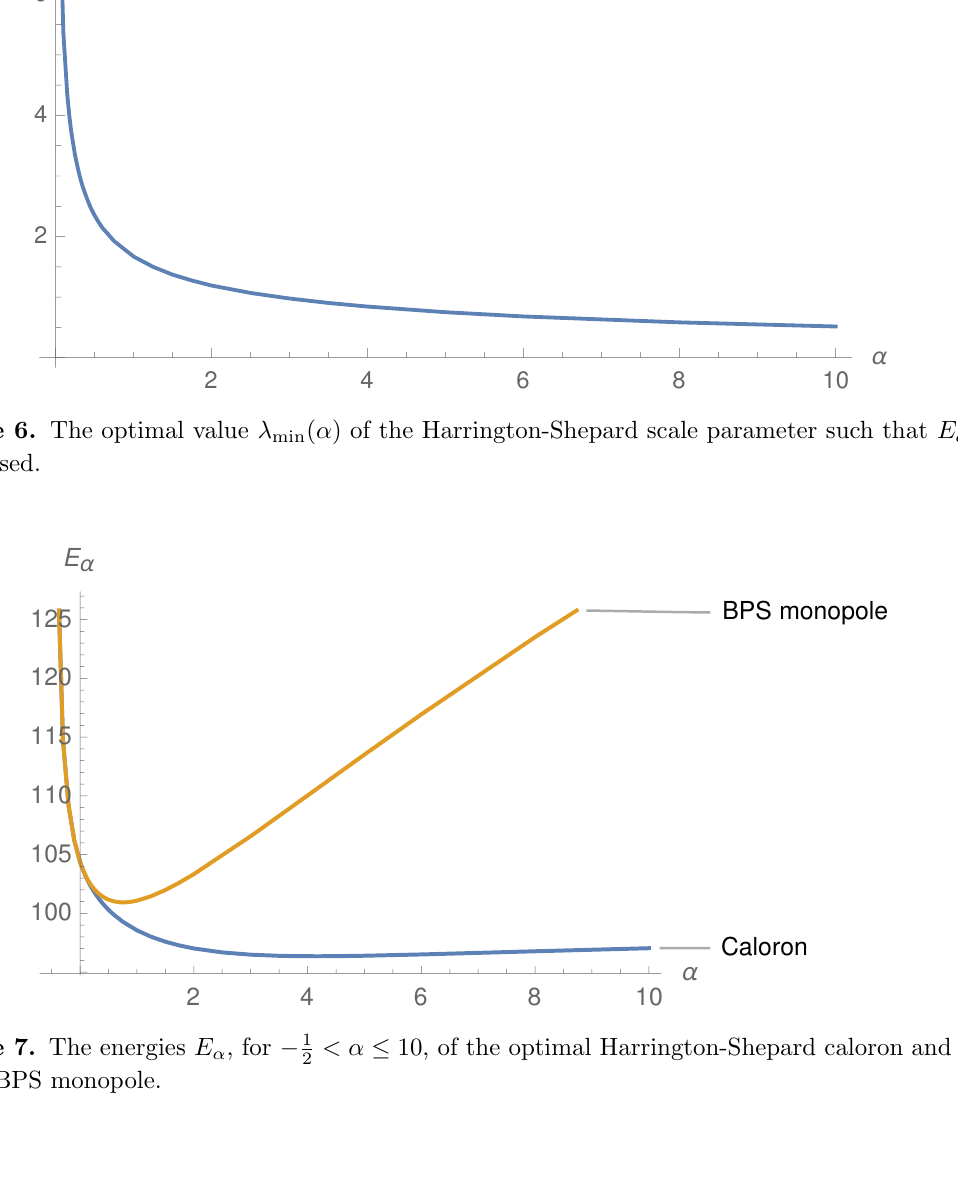
Figure 7. The energies E (cid:11) , for (cid:0) 1 (cid:23) = (cid:25) BPS